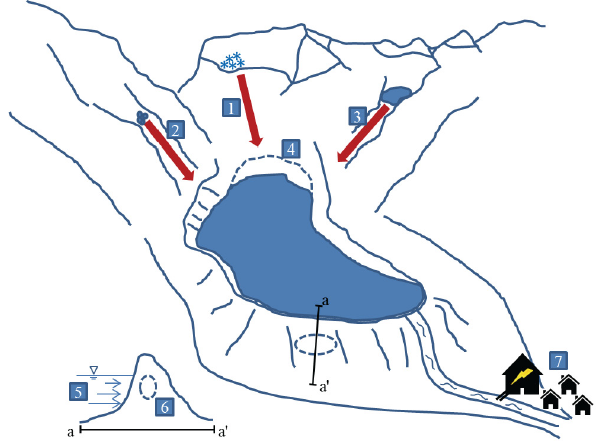
Figure 2. Schematic of GLOF hazard parameters used in the new method: (1) snow/ice avalanche, (2) rockfall, (3) flood from up- stream lake, (4) lake expansion, (5) hydrostatic pressure, (6) ice- cored moraine, and (7) downstream